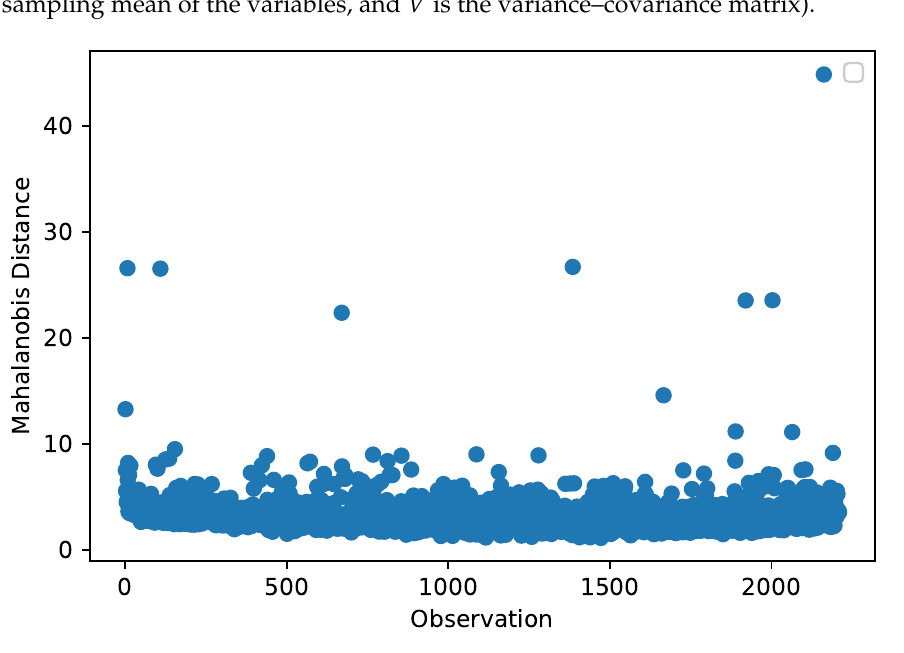
Figure 5. Mahalanobis Distance and Outlier